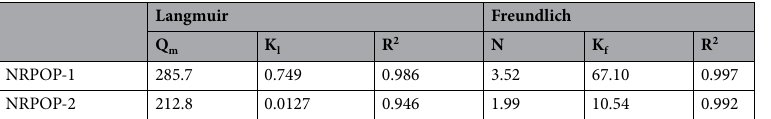
Table 2. Langmuir and Freundlich parameters for the adsorption of Iodine. Langmiur model: Q m = maximum monolayer coverage capacity (mg g −1 ), K l = Langmuir isotherm constant (L mg −1 ); Freundlich model: K f = Freundlich isotherm constant (mg g −1 ), N = adsorption intensity; R 2 is the correlation coefficient of the linear fit.